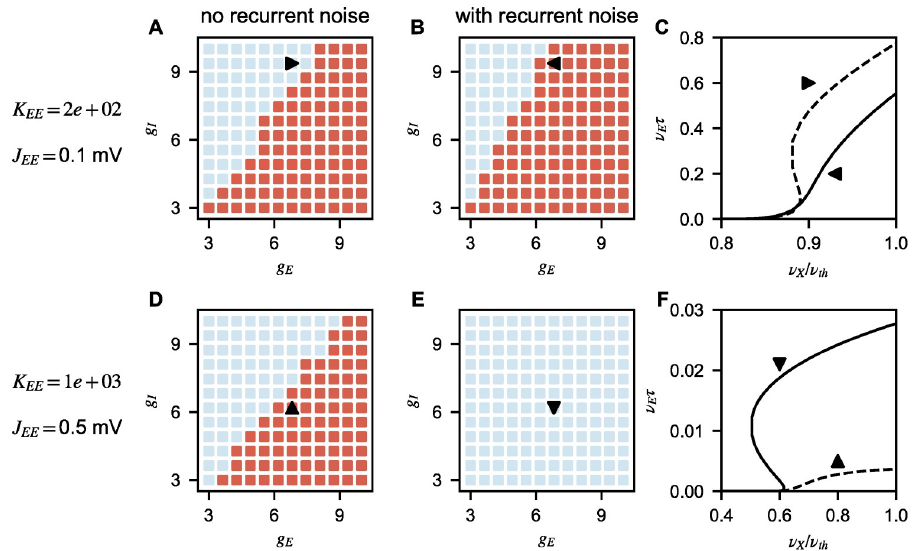
Fig 7. Role of recurrent noise in generating multiple solutions at onset in model B. Number of solutions for and g (red and blue correspond to single solution and multiple solutions, respectively) different combinations of g E I computed without (first column) and with (second column) recurrent noise; the third column shows transfer functions for specific combinations (indicated by triangles in the first two columns). Both for small (first row) and large (second row) K, noise influences the number of solutions. ( A - C ) For some parameters, noise reduces the size of the region with multiple solutions. ( D - F ) For others, noise increases the size of the region with multiple solutions. Parameters: J = J , g = g = 1, α = α = IE EE IX EX I E